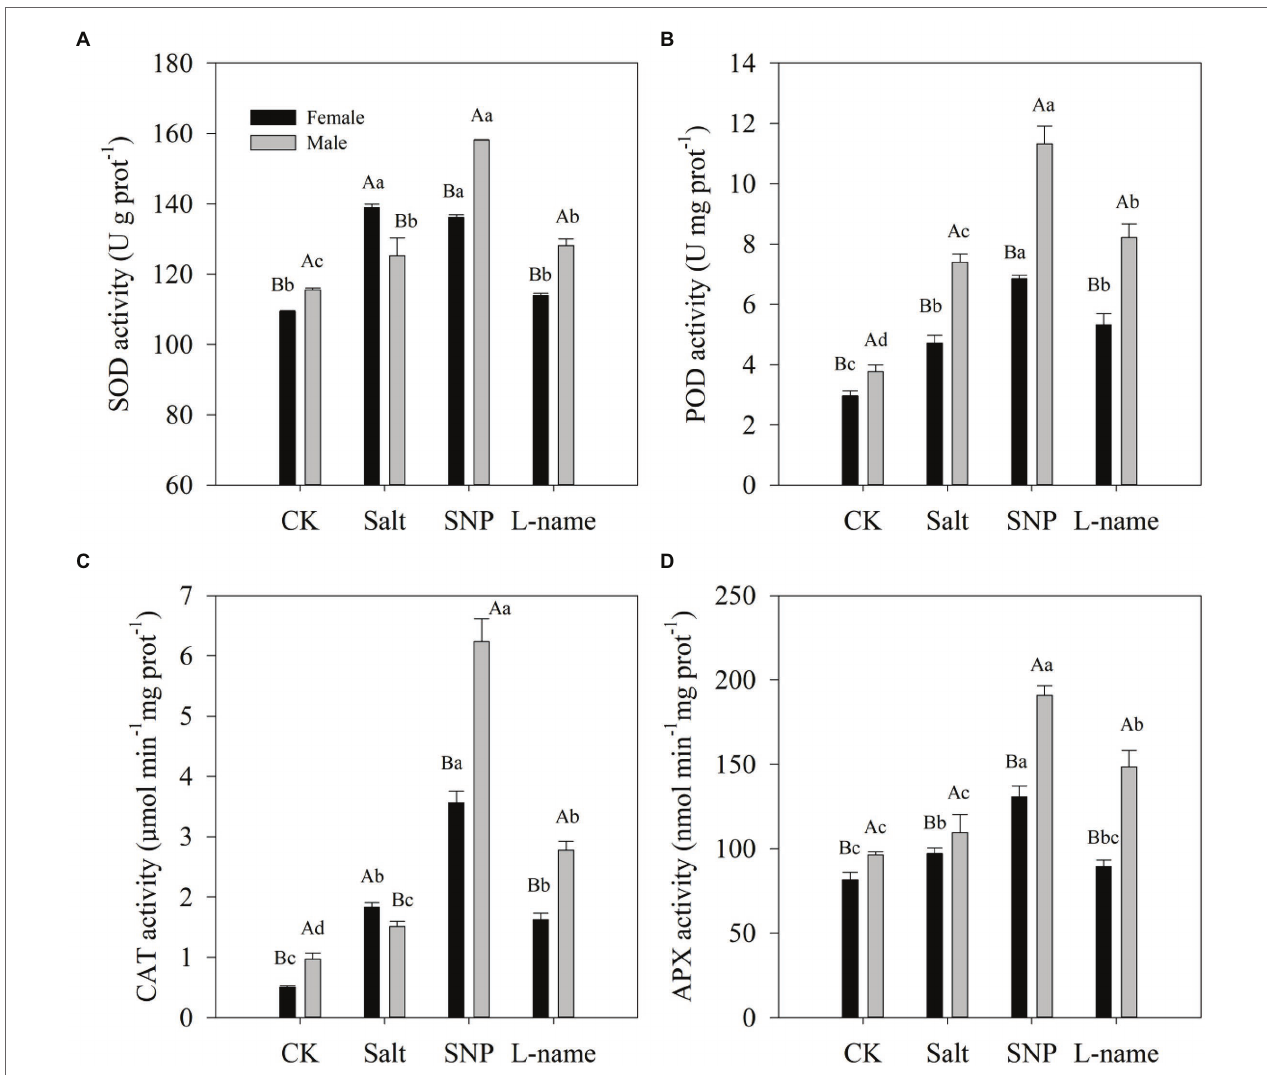
FIGURE 7 | Antioxidant enzyme activities of T. grandis in response to different treatments. CK (control, distilled water), salt (100 mM NaCl), SNP (100 mM NaCl with 0.05 mM SNP), and L-name (100 mM NaCl with 0.5 mM SNP and L-name). Different uppercase letters indicate a significant difference between different genders at p < 0.05, and different lowercase letters indicate significant difference under salt treatment at p < 0.05, according to Duncan’s